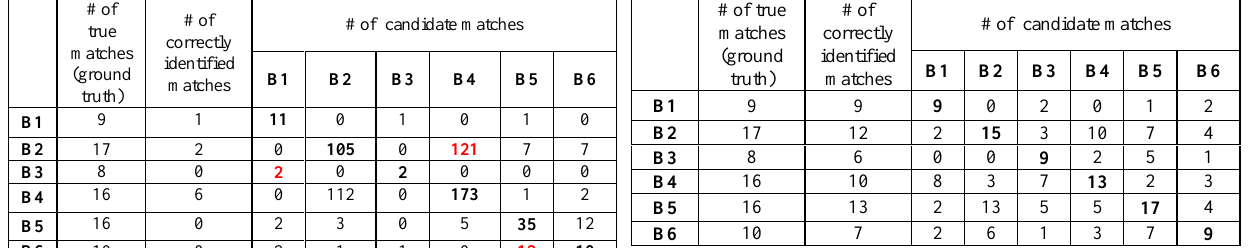
Table 3. Improved geometric hashing: Truth table of the matching